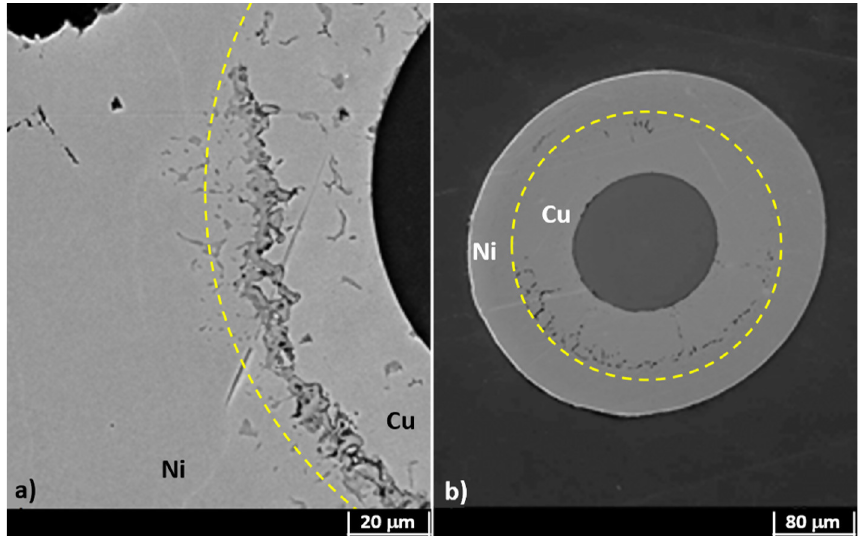
Figure 5. SEM micrograph of a bimetallic coating after the first heating/cooling cycle between room temperature (RT) and 800 ◦ C: ( a ) Cu coating thinner than the Ni one; ( b ) double layer with comparable thicknesses. Cu–Ni boundaries are highlighted by a yellow thin dotted line; it represents the region where the Cu–Ni alloy was formed.